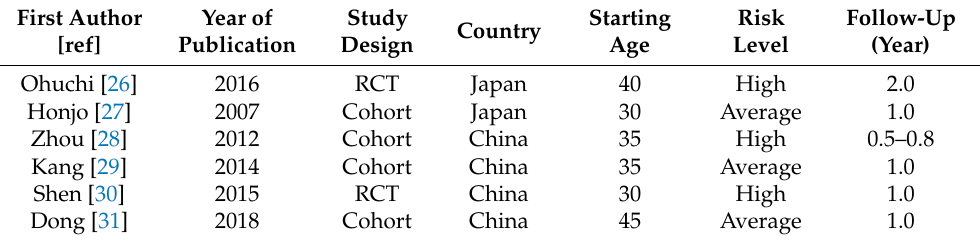
Abbreviations: RCT = Randomized clinical